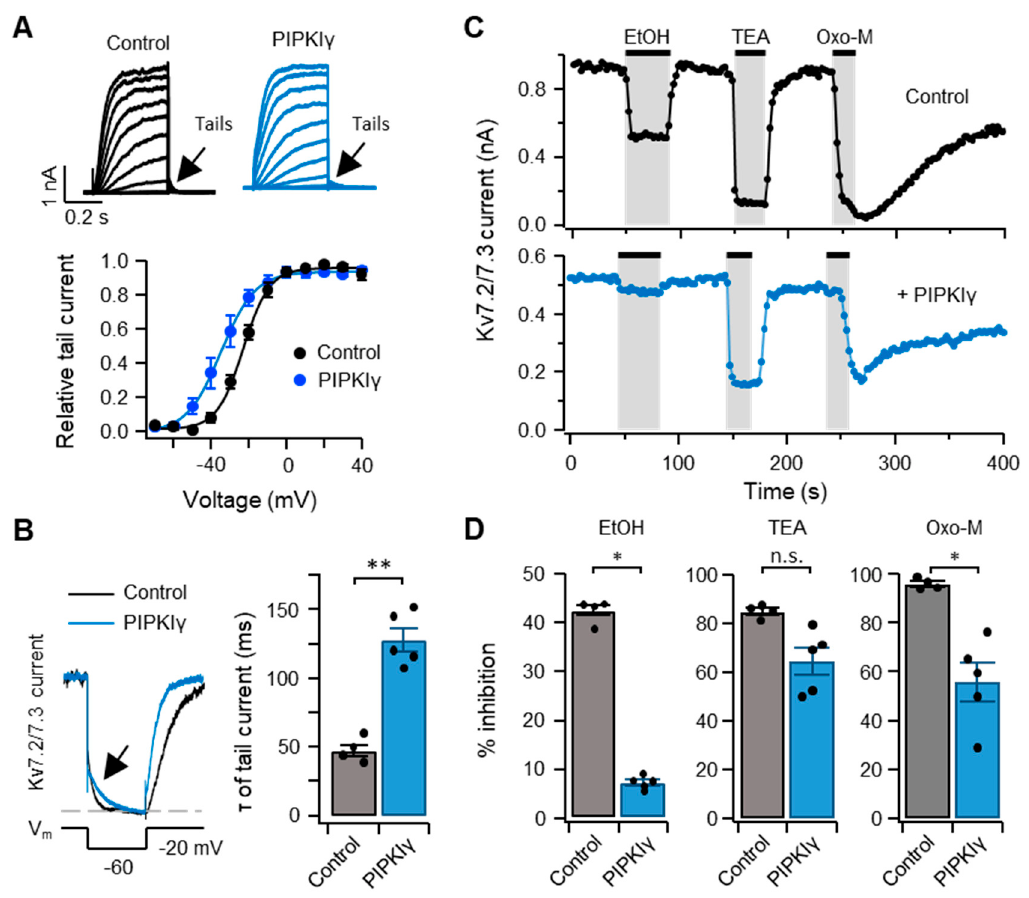
Figure 5. Kv7.2 / 7.3 currents in transfected tsA201 cells are inhibited by an increase in plasma membrane phosphatidylinositol 4,5-bisphosphate (PI(4,5)P 2 ) using phosphatidylinositol phosphate 5-kinase type 1 γ (PIPKI γ ). ( A ) Tail currents elicited using increasing voltage steps applied to tsA201 cells untransfected (black symbols) or overexpressing PIPKI γ (blue symbols). The holding potential was − 80 mV. ( B ) Representative traces and the time constant for deactivating of Kv7.2 / 7.3 currents exhibited by tsA201 cells untransfected (black symbols) or overexpressing PIPKI γ (blue symbols). Time-course ( C ) and percent inhibition ( D ) of Kv7.2 / 7.3 currents upon sequential treatments of 400 mM ethanol, 30 mM tetraethylammonium (TEA), and 10 µ M Oxo-M in tsA201 cells untransfected (control) or overexpressing PIPKI γ . Data are mean ± SEM. n = 5 each. Mann–Whitney u -test, * p < 0.05, ** p < 0.01.